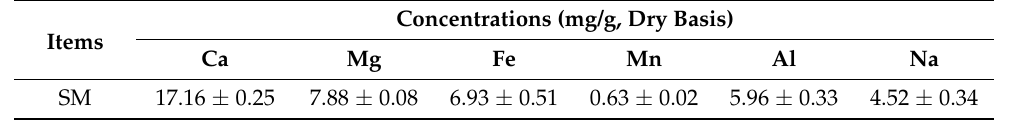
Table 1. Some important metal contents in raw SM feedstocks.